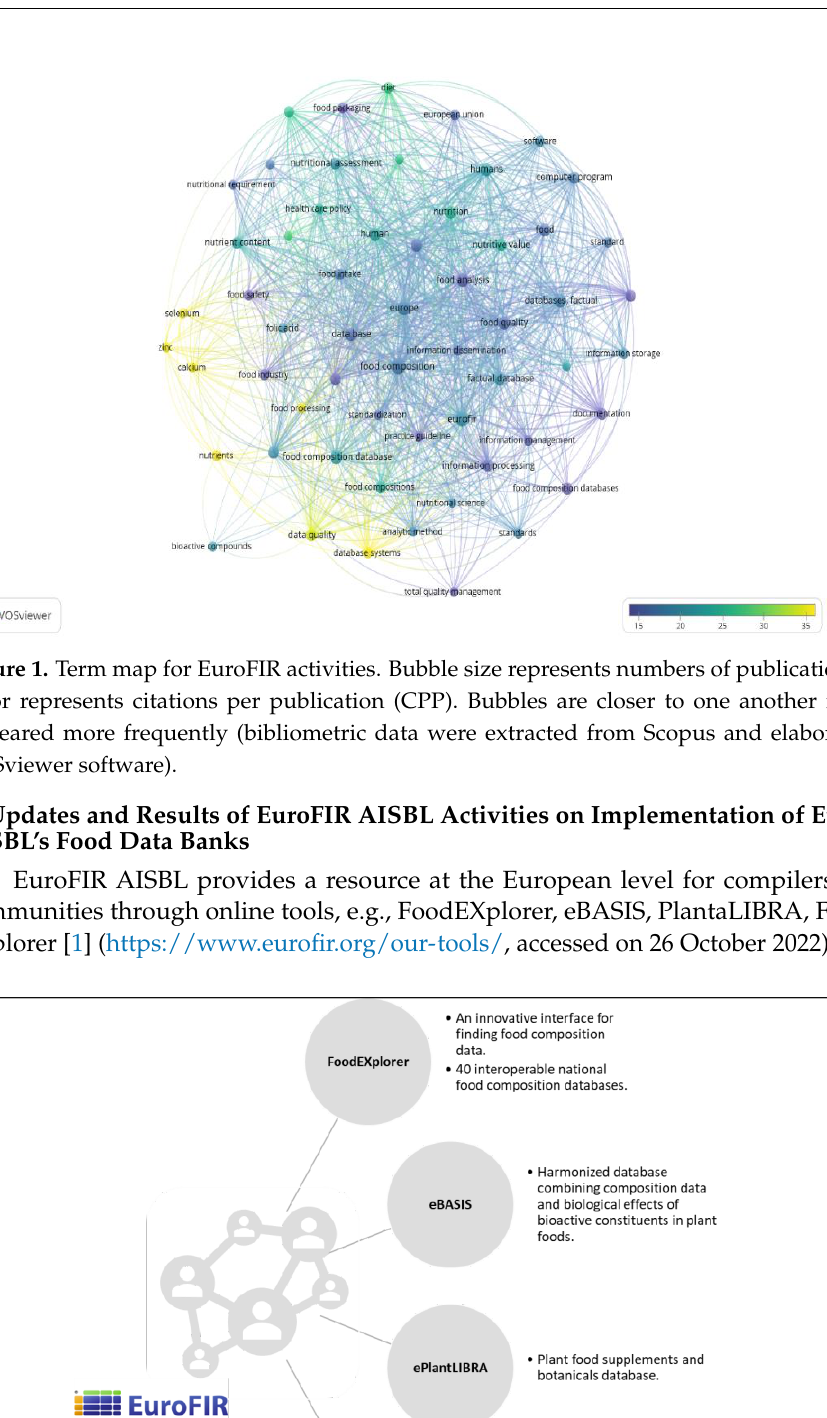
Figure 2. Representation of main EuroFIR AISBL